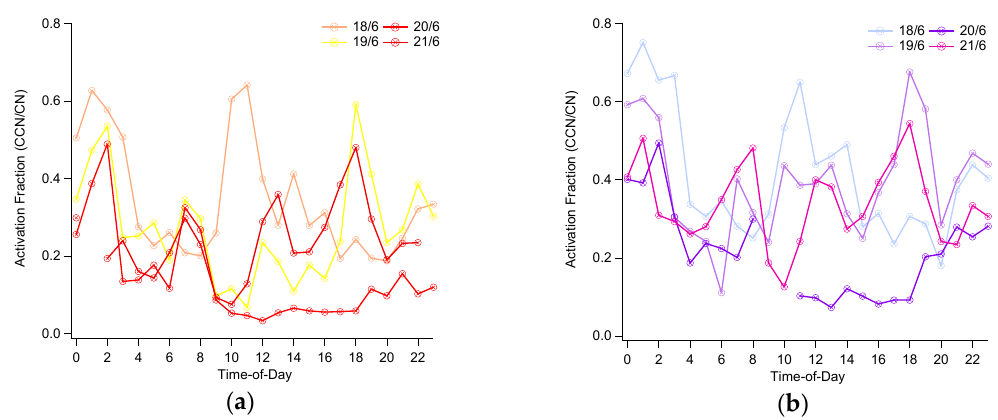
Figure 2. Diurnal variability of the activation fractions (CCN/CN) during the measurement period for: ( a ) 0.4% supersaturation; ( b ) 0.8% supersaturation. Activation fractions between 0.6–1% supersaturation did not differ considerably.